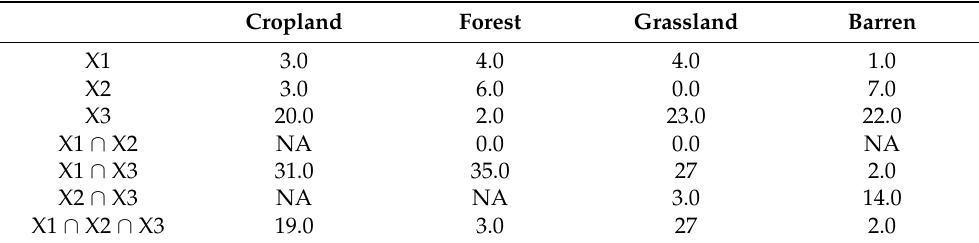
Table 5. Influence of environmental factors on NDVI on the four land cover types using RDA method (X1 represents climatic factors (temperature, precipitation), X2 denotes topographic factors (altitude, slope, aspect), X3 represents geographic location factors (longitude, latitude), X1 ∩ X2 denotes the interaction influence between climatic factors and topographic factors, and so on. “NA” denotes the values < 0, “0.0” denotes the values are very close to 0). Cropland Forest Grassland Barren X1 3.0 4.0 4.0 1.0 X2 3.0 6.0 0.0 7.0 X3 20.0 2.0 23.0 22.0 X1 ∩ X2 NA 0.0 0.0 NA X1 ∩ X3 31.0 35.0 27 2.0 X2 ∩ X3 NA NA 3.0 14.0 X1 ∩ X2 ∩ X3 19.0 3.0 27